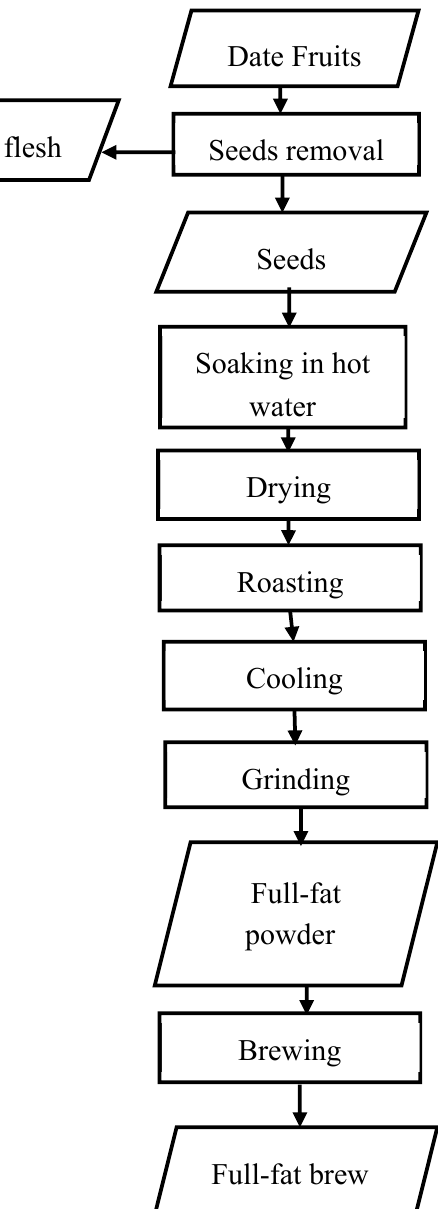
Figure 1. Production flow chart of the brew from the full-fat roasted date seeds.